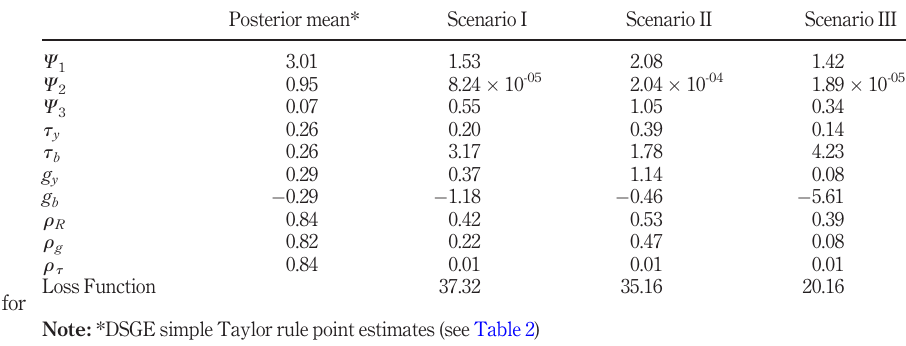
Table III. Preferences weights for monetary and fi scal